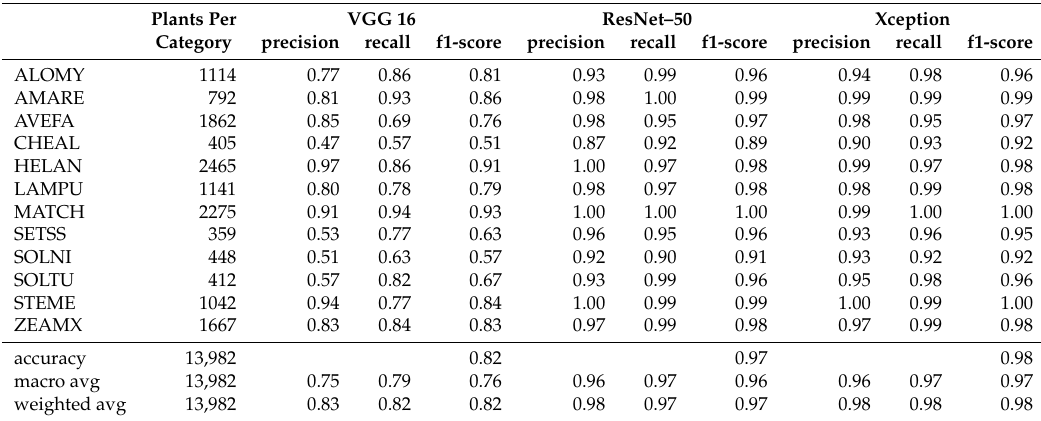
Table 6. Precision , recall and f1-score for the first repetition of all three Neural Networks that were tested. These results derive from testing the networks only on the testing proportion of the dataset. Plants Per VGG 16 ResNet–50 Xception Category